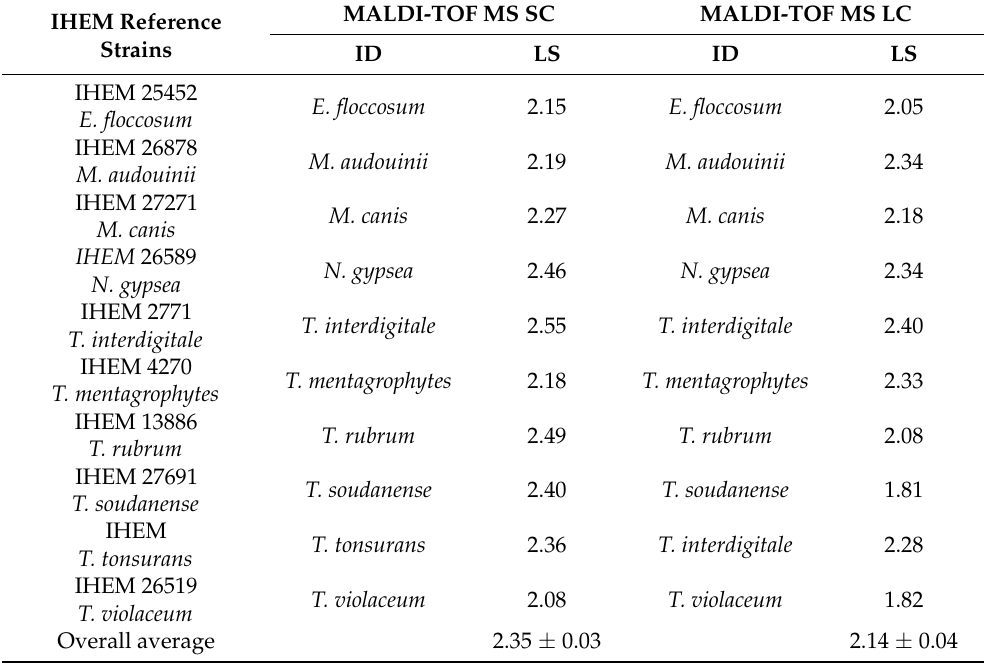
Table 1. Validation of the liquid media MALDI-TOF MS protocol using BCCM/IHEM reference strains. The mean log score of all four spots (LS) of the liquid (LC) and solid cultures (SC) are listed, as well as their identity at species level